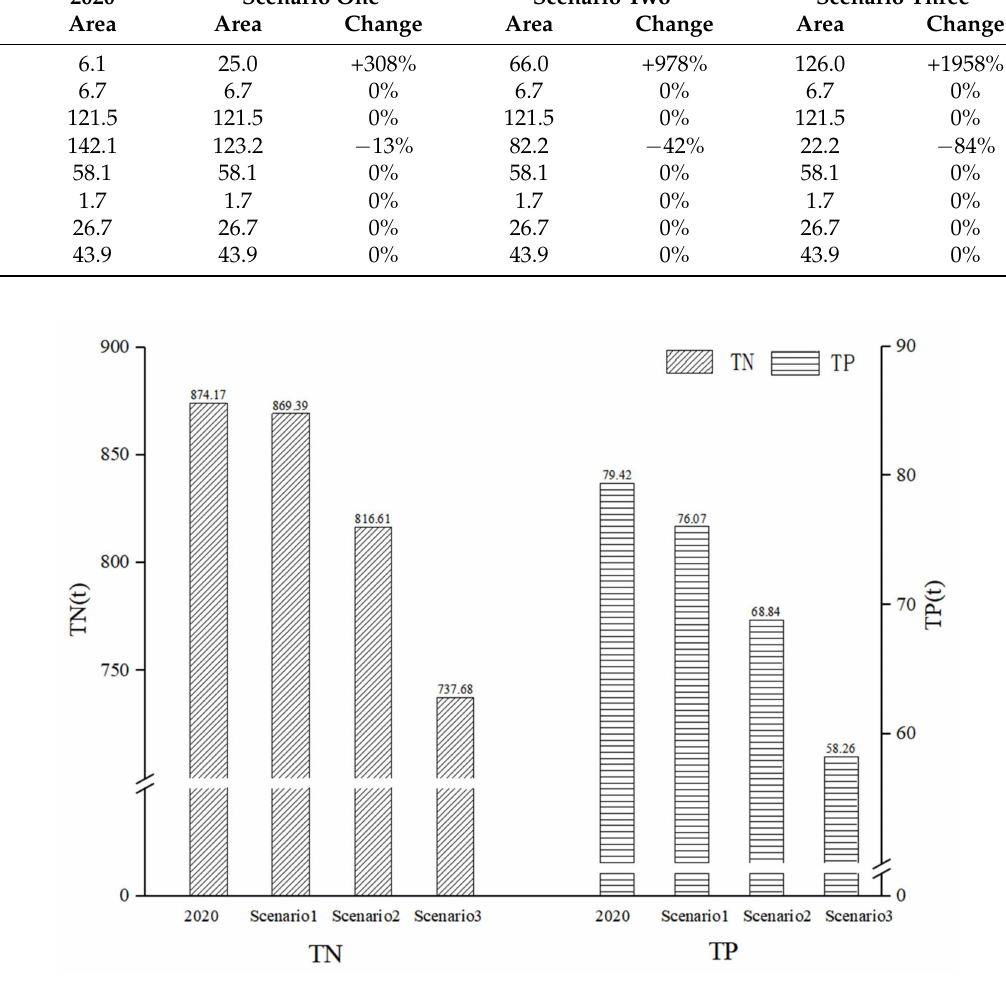
Figure 8. TN and TP loads at the basin outlet of the different